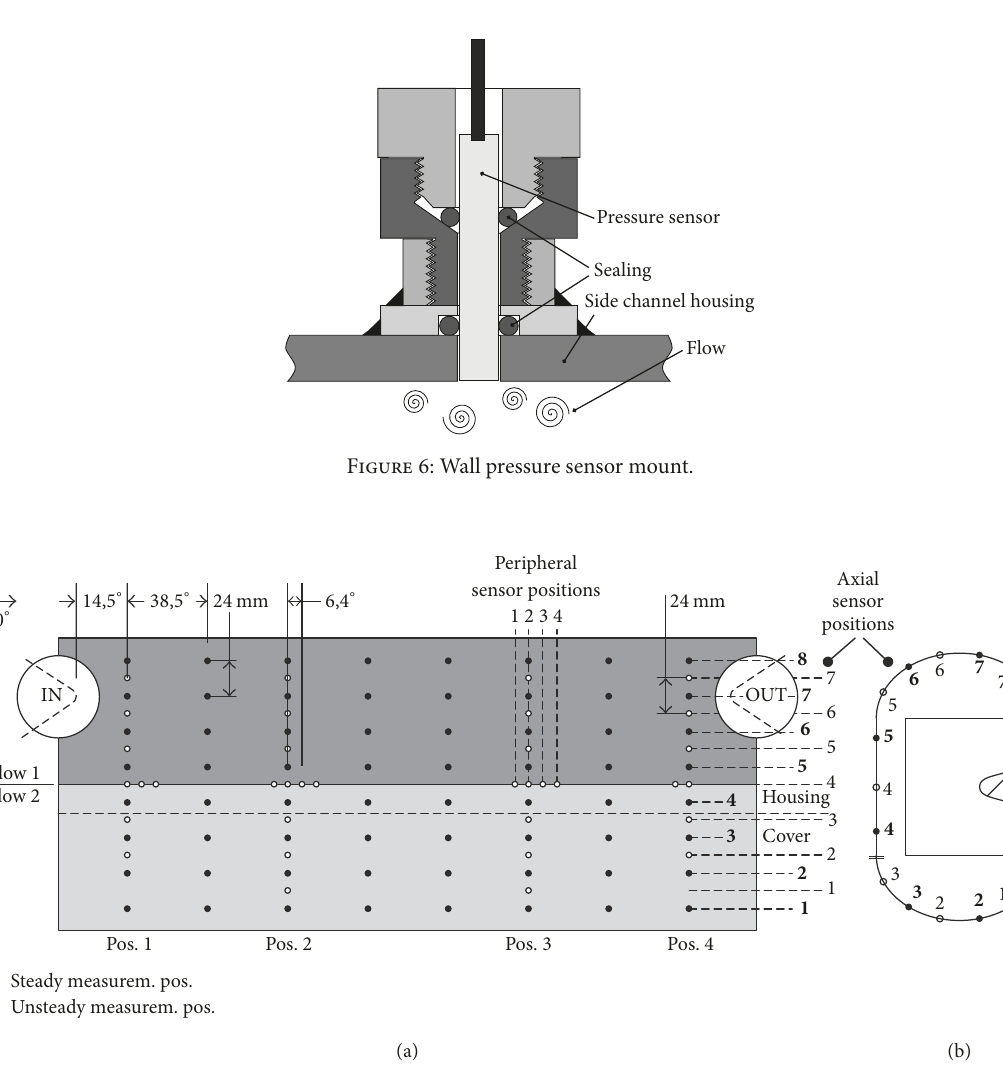
Figure 7: Measurement positions for wall pressure measurements: unwrapped side channel (a), axial cut (b). 𝜑 = 0 ∘ is located in the middle of the stripper. First column of measurementpositions (Pos. 1) is located at an absolute angle of 45.1 ∘ . Axial sensor positions marked with bold numbers depict steady measurements positions of the Pressure Systems DTC Initium. Axial sensor positions marked with normal numbers depict unsteady measurements positions of the Kulite pressure